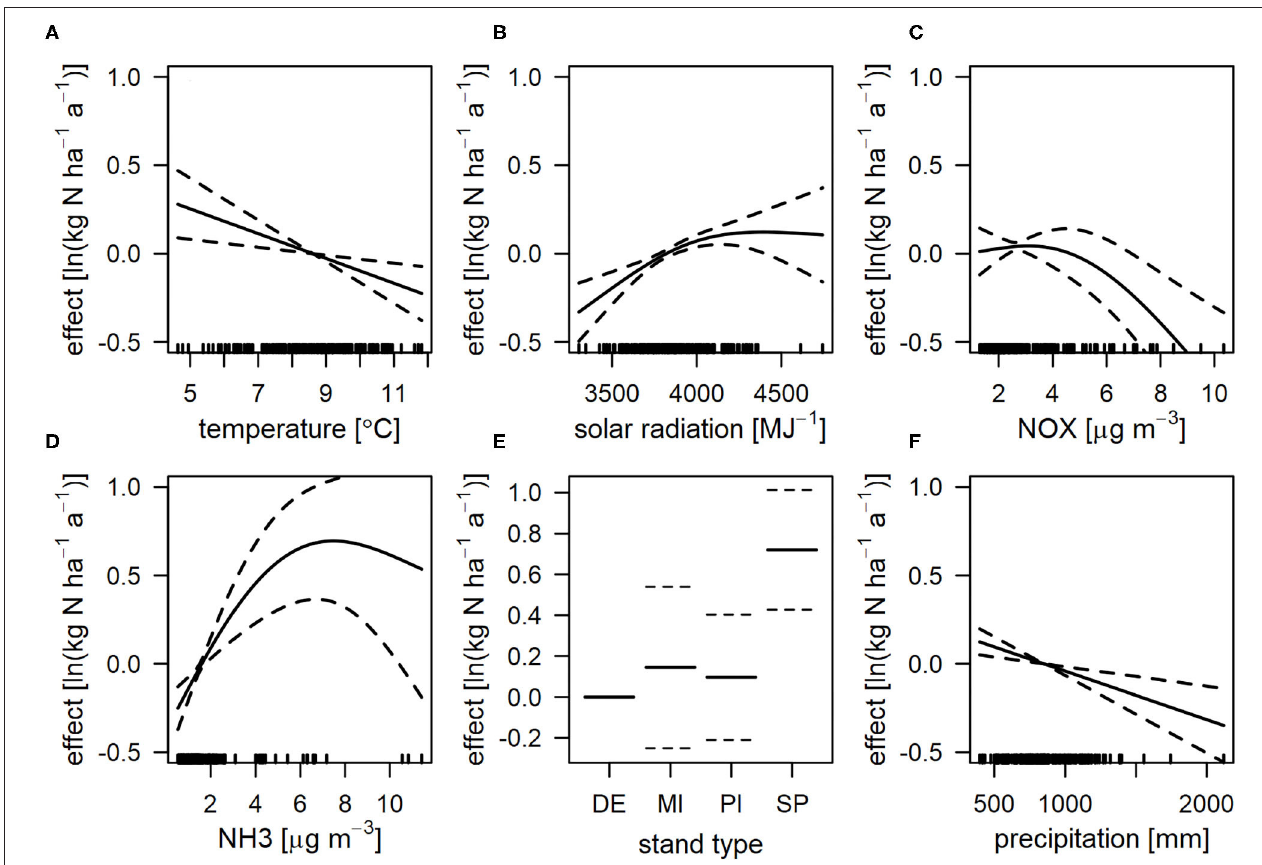
FIGURE 7 | Partial effect of temperature (A) , solar radiation (B) , NO X concentration (C) , NH 3 concentration (D) , stand type (E) , and precipitation (F) on 1 TIN between the inferential (IFM) and emission based method (EBM) for dry deposition (A–E) , and total deposition (F) . Positive effects indicate a tendency for higher TIN deposition estimates of the IFM compared to the EBM. Note the log-transformed data. Dashed lines indicate 95% pointwise prognosis intervals. The covariate is displayed as marks along the x-axis. (DE, deciduous forest; MI, mixed forest; PI, pine forest; SP, spruce